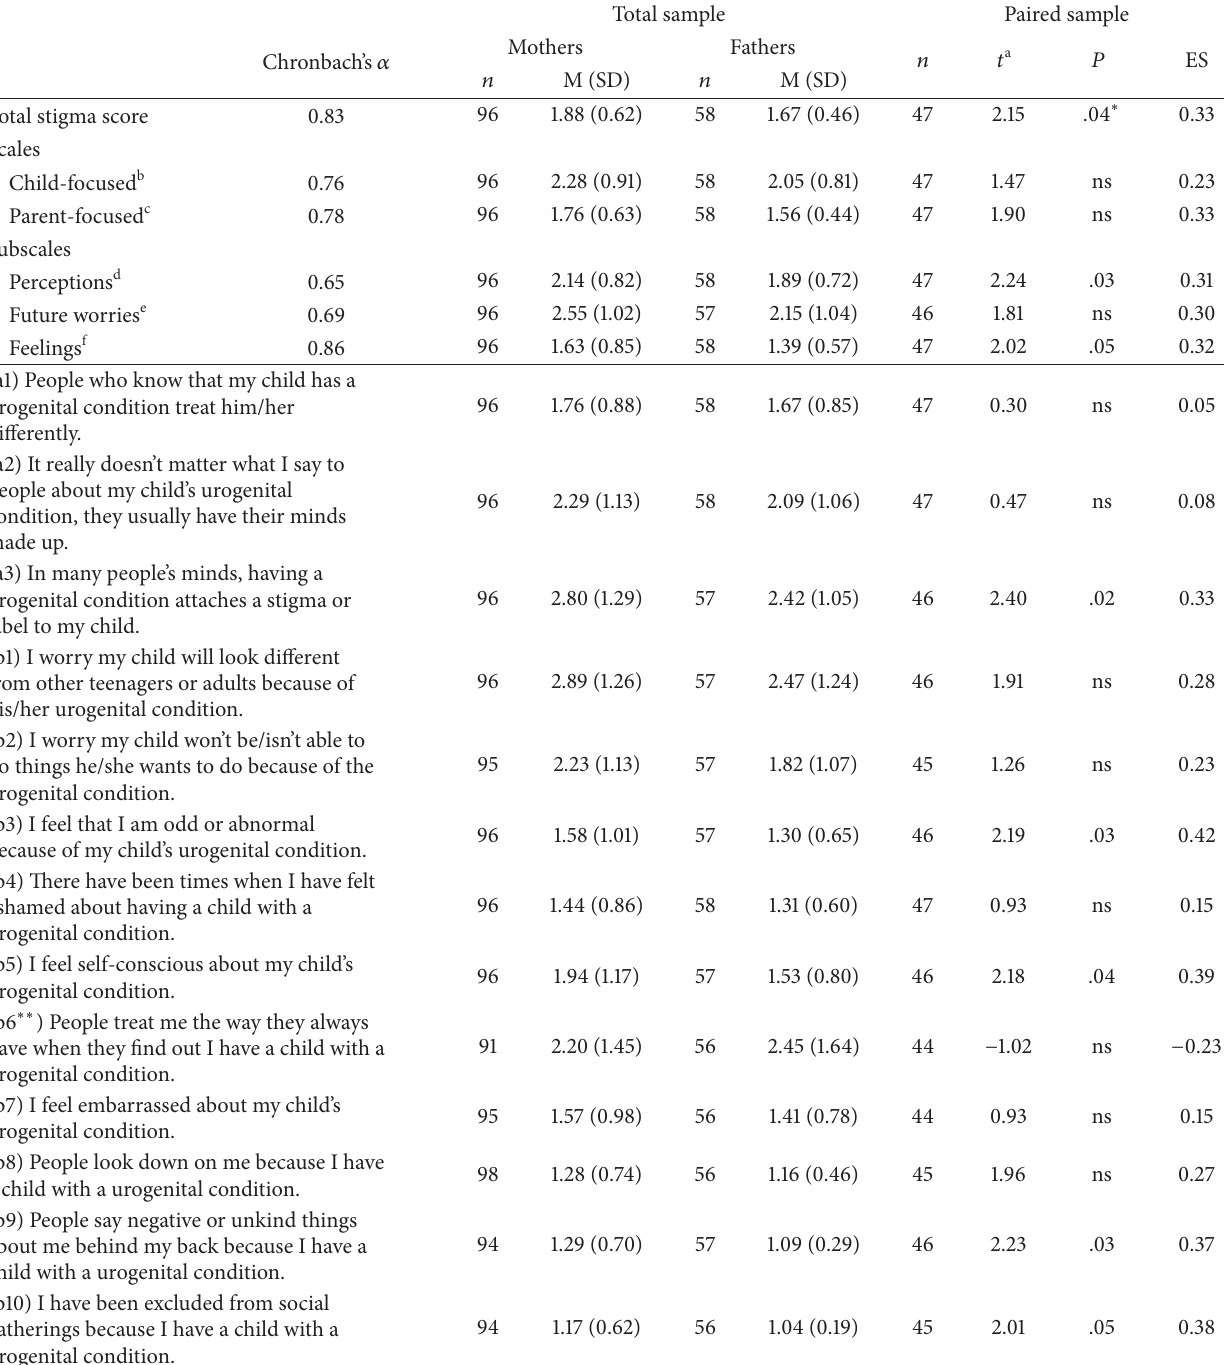
Table 4: Stigma scale reliability, descriptive statistics, and informant